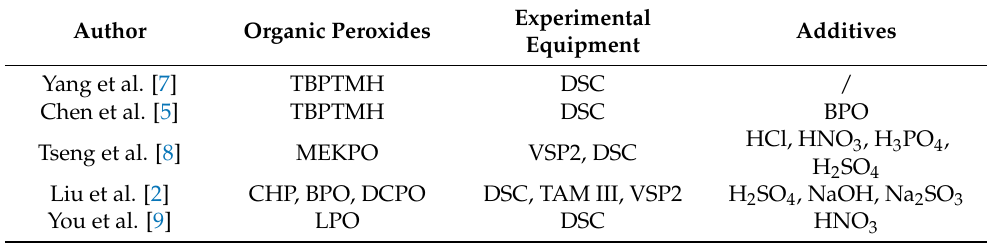
Table 1. A brief overview of the